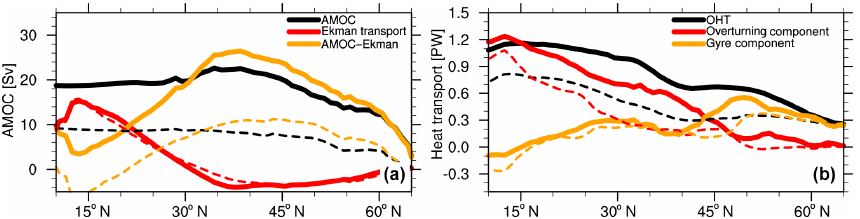
Figure 5. (a) Time-mean Atlantic meridional overturning circulation, the Ekman transport and the geostrophic volume transport ( ≈ AMOC– Ekman), (b) time-mean Atlantic meridional heat transport (OHT) with the overturning component and the gyre component (in PW). The historical simulation (1850–1950) is shown by solid lines, RCP 8.5 (2200–2300) by dashed